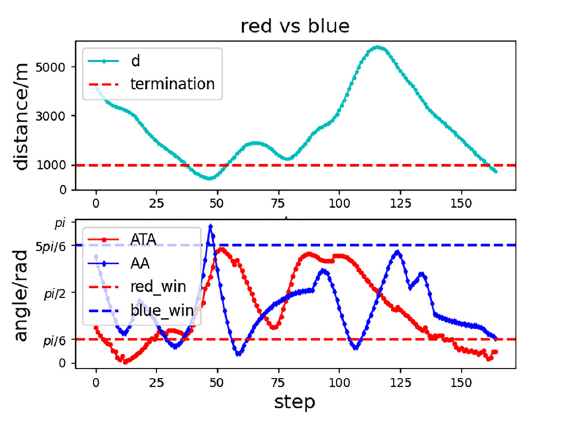
Figure 19. The changes of ATA , AA and d in the later training period in case